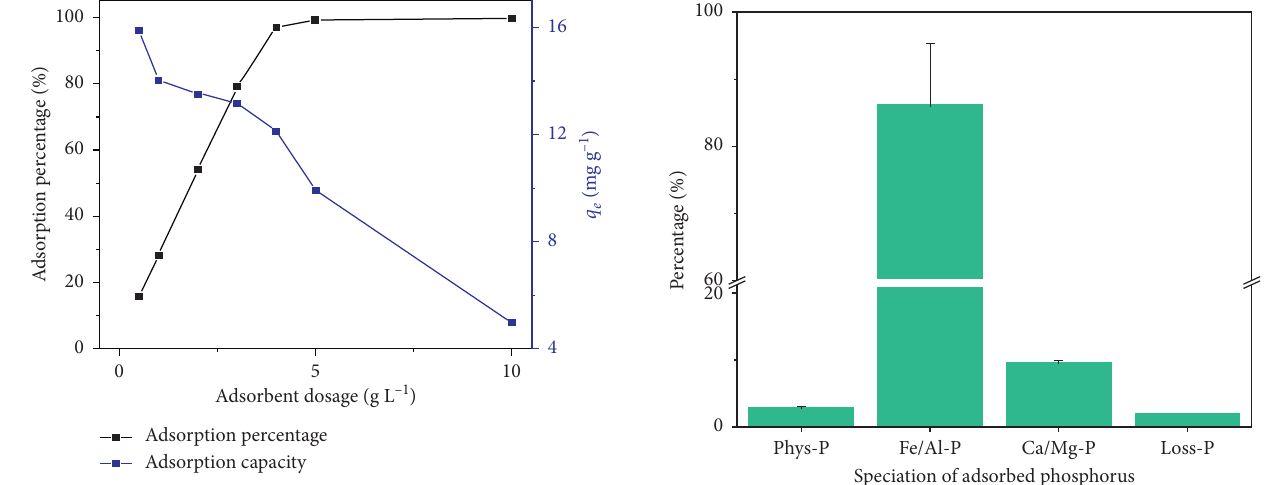
Figure 9: The effect of dosage on phosphorus adsorption (pH � 7, t � 10 min, 120rpm, initial phosphorus concentration � 50mg · L − 1